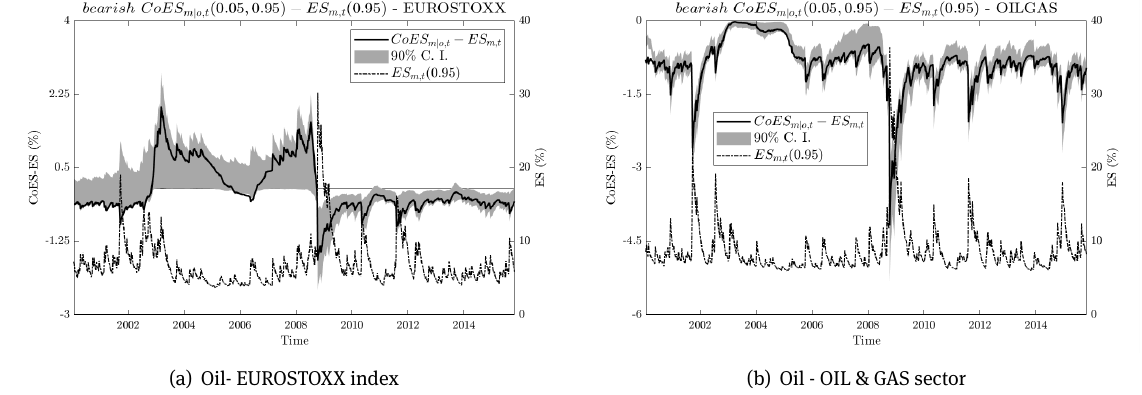
Figure 19a: CoES m | o , t (0.05, 0.05) for a certain sector given a bearish scenario for oil prices